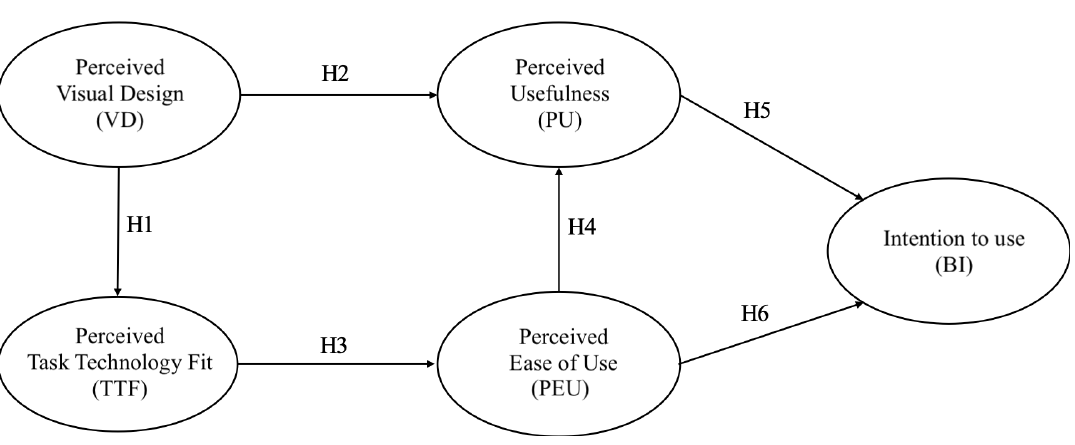
Figure 6. Conceptual research model [26]. The circles represent the constructs measured by a set of items, with arrows representing hypotheses 1 to